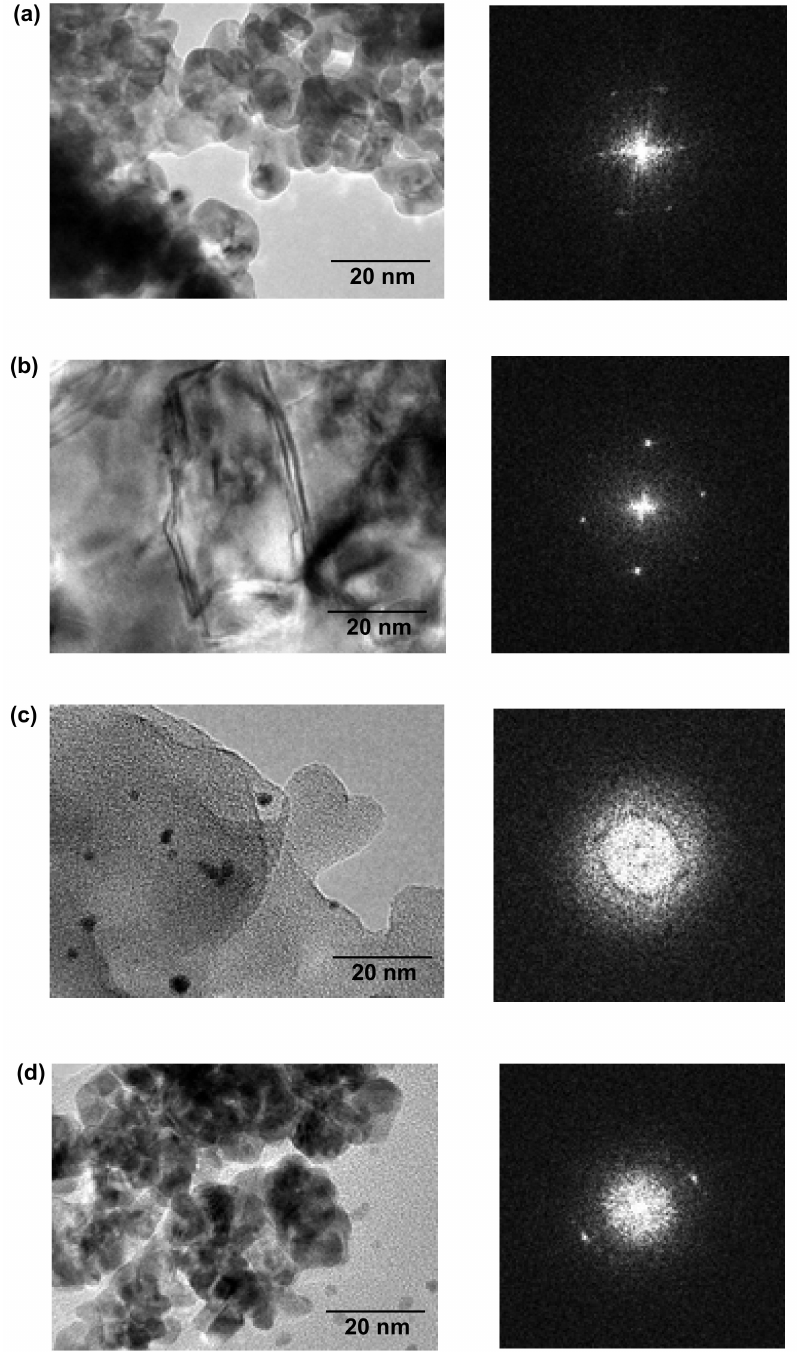
Figure 3. HRTEM images of ( a ) Pd 0 /poly(DVB)-100%; ( b ) Pd 0 /poly (DVB-co-St)-100%; ( c ) Pd 0 /poly(EDMA)-100%; ( d ) Pd 0